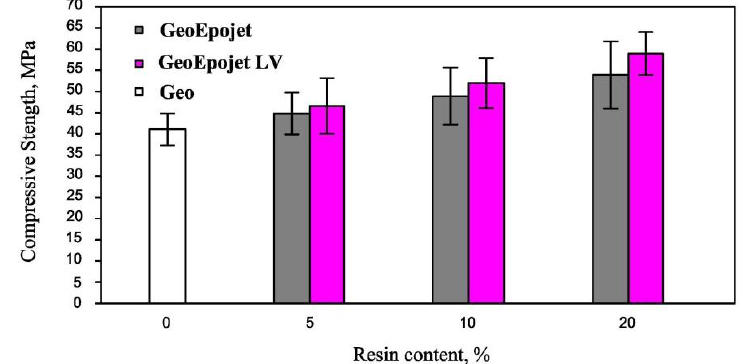
Figure 10. Compressive strength of the geopolymer, hybrid GeoEpojet and GeoEpojetLV specimens as function of resin